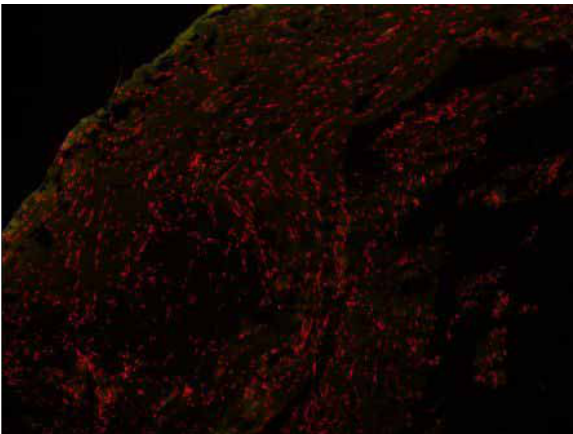
figure 2 - Group II. Microscopic fluorescence immunohisto- chemistry for the detection of active caspase-3. Increase